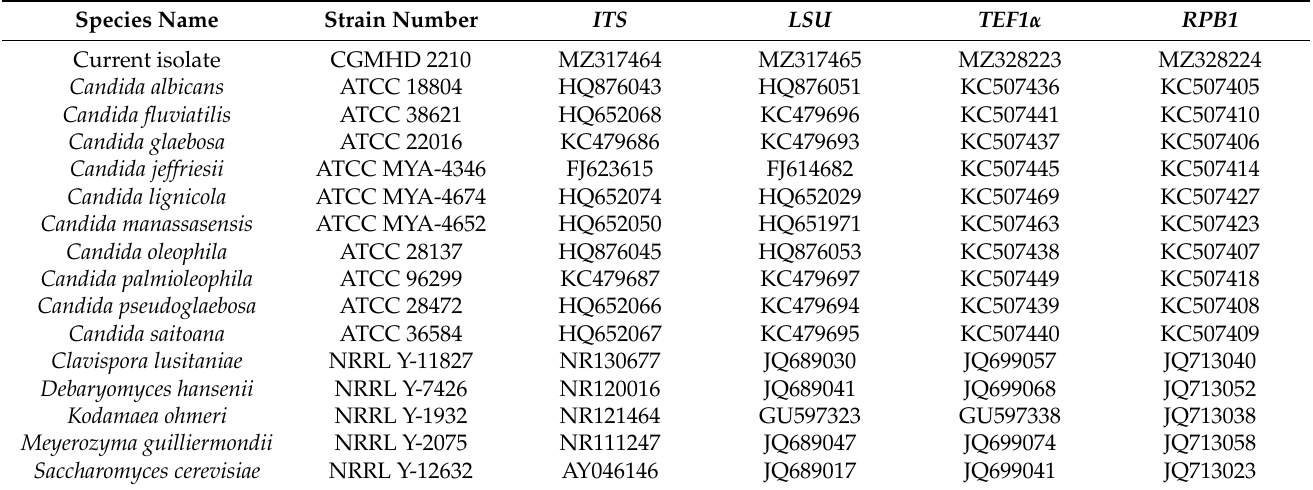
Figure 5. Maximum-likelihood phylogenetic tree based on combined ITS-LSU-TEF1a-RPB1 sequences. The Tamura 3-parameter model was used as the substitutional model. A discrete gamma distribution was used to model evolutionary rate differences between sites. The rate variation model allowed for some sites to be evolutionarily invariable. Bootstrap values are shown at the nodes. The scale bar indicates the number of substitutions per site. Saccharomyces cerevisiae was used as an outgroup. Table 1. Sequences used to construct the phylogenetic tree.